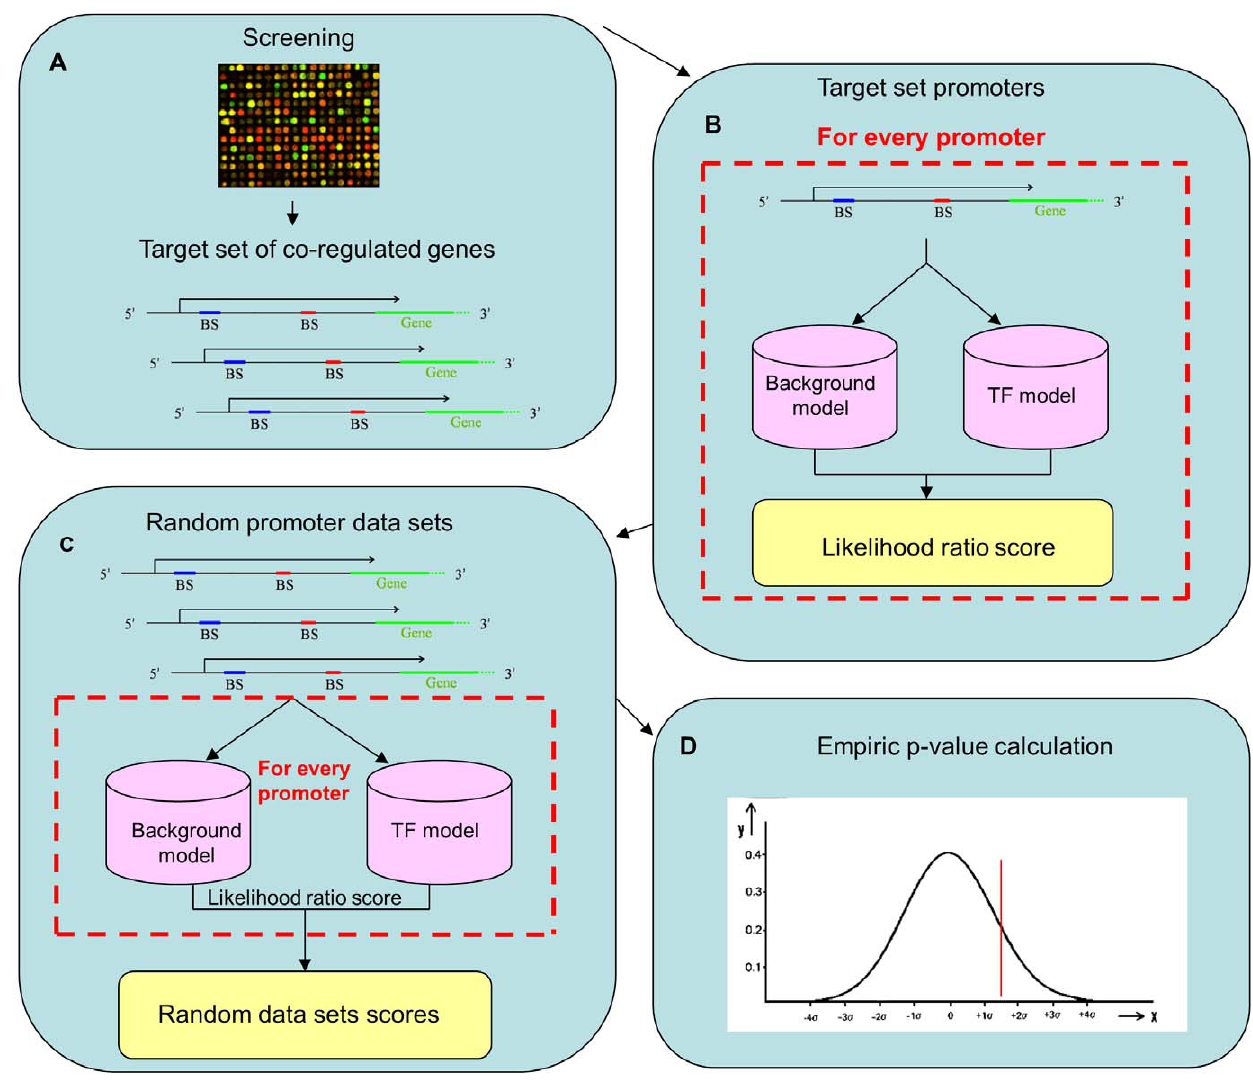
Figure 2. Schematic of the DEMON’s algorithm work flow. a. Retrieving a list of co-expressed genes from high-throughput experiments. b. For each HMM-promoter pair a score is computed as the ratio between the probability to emit the promoter sequence using the TFBS HMM and the probability to emit the promoter sequence using a background HMM. The sum of scores for each TF is used for computing a single score reflecting the TF’s overall abundance in the input promoter set. c. Randomly selecting 100 promoter data sets with the same size as the original data set. Scores are calculated as before for those data sets. d. Each TF is assigned with an empirical p-value defined as the percentage of random cases in which it scored higher.